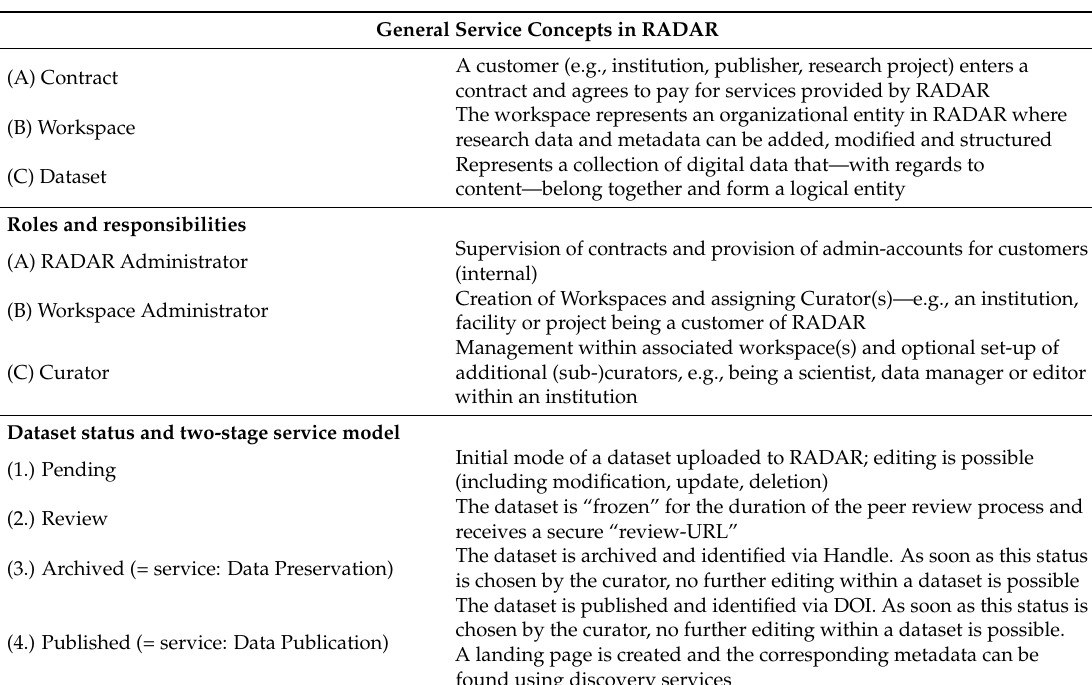
Table 1. Service concepts, roles and dataset status of the RADAR repository